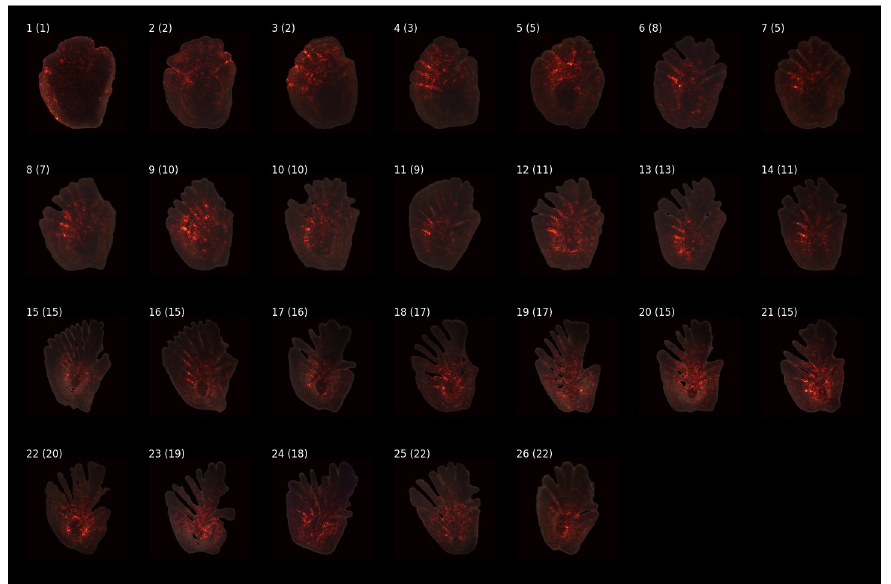
Fig 11. Feature relevance heatmaps produced by integrated gradients. The integrated gradients technique is applied to a selection of otolith images. The number in the parenthesis displays the age predicted by the deep learning model.